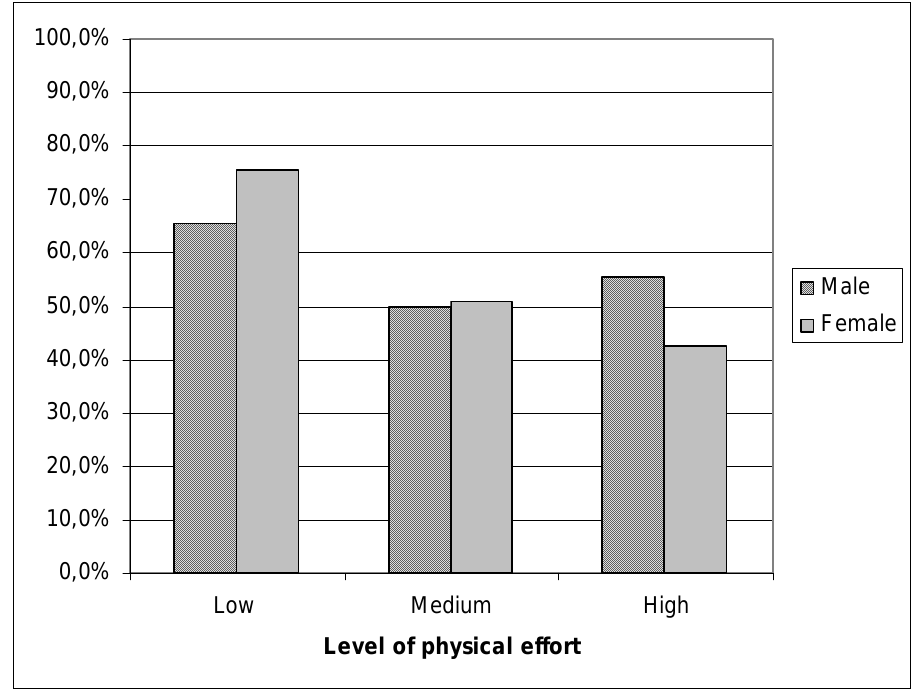
FIGURE 1. Level of physical effort reported by males and females (male, n = 484; female, n = 502, 7 people missing).